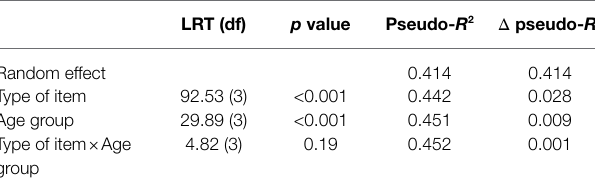
TABLE 9 | Results of the linear mixed model on RTs in Experiment